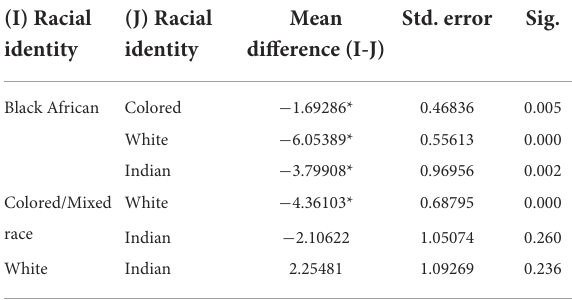
*Themeandifferenceissignificantatthe0.05level.